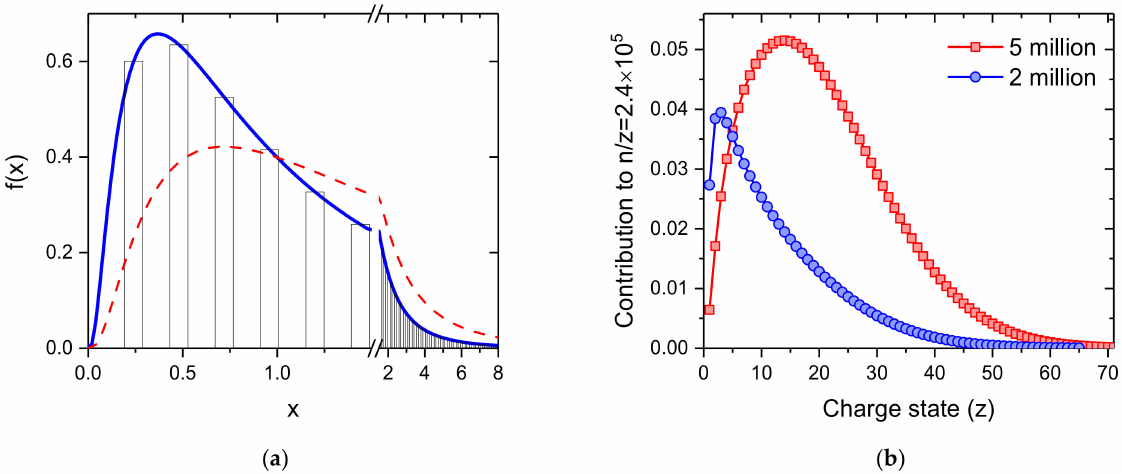
Figure 6. ( a ) log-normal distribution with an average value of 1, resembling the size distribution of the neutral helium droplets. An electrostatic quadrupole bender selects differently charged droplets having the same mass-per-charge value, indicated by the bars. The red dashed line indicates the amounts of dopants being picked up by the differently sized He droplets; ( b ) shows the relative ion yield of different charge states the mass-per-charge selected helium droplets with n / z = 2.4 × 10 5 He atoms per charge for neutral log-normal droplet size distributions having average sizes of 2 million (blue circles) and 5 million (red squares) He